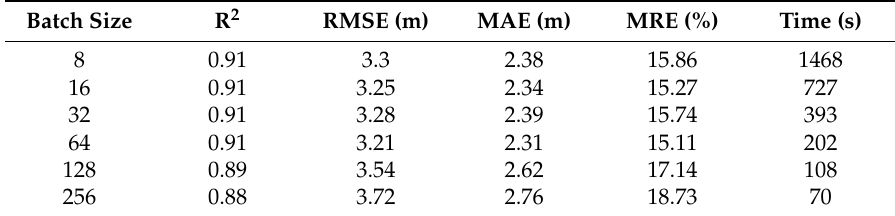
Table 5. Error statistics of di ff erent batch size.